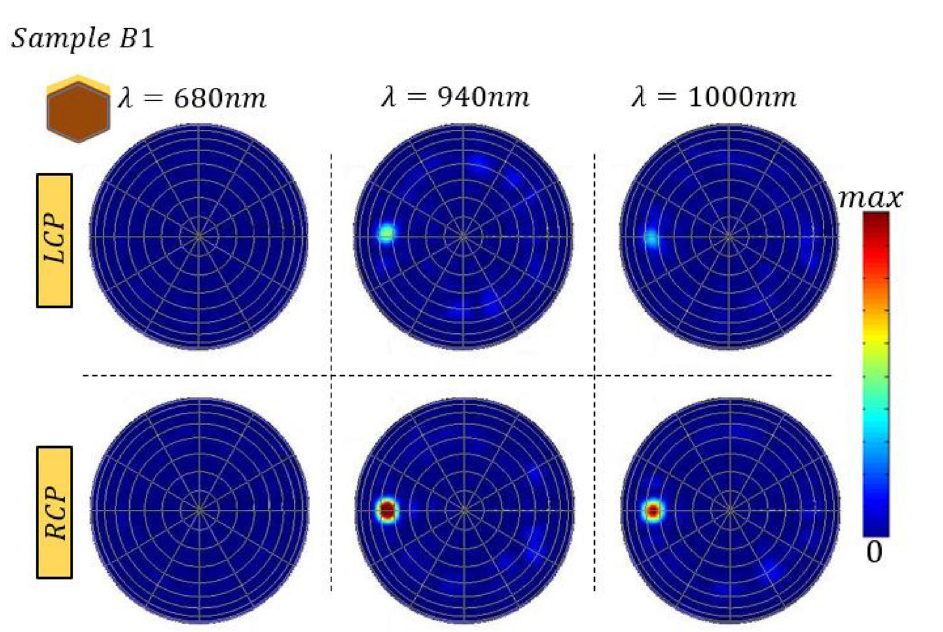
= 0°, and ( b ) = 90°. ( c ) = 90° (top) and = 180° (bottom). ( d ) RCP ϕ ϕ = 0°. ϕ ϕ ϕ